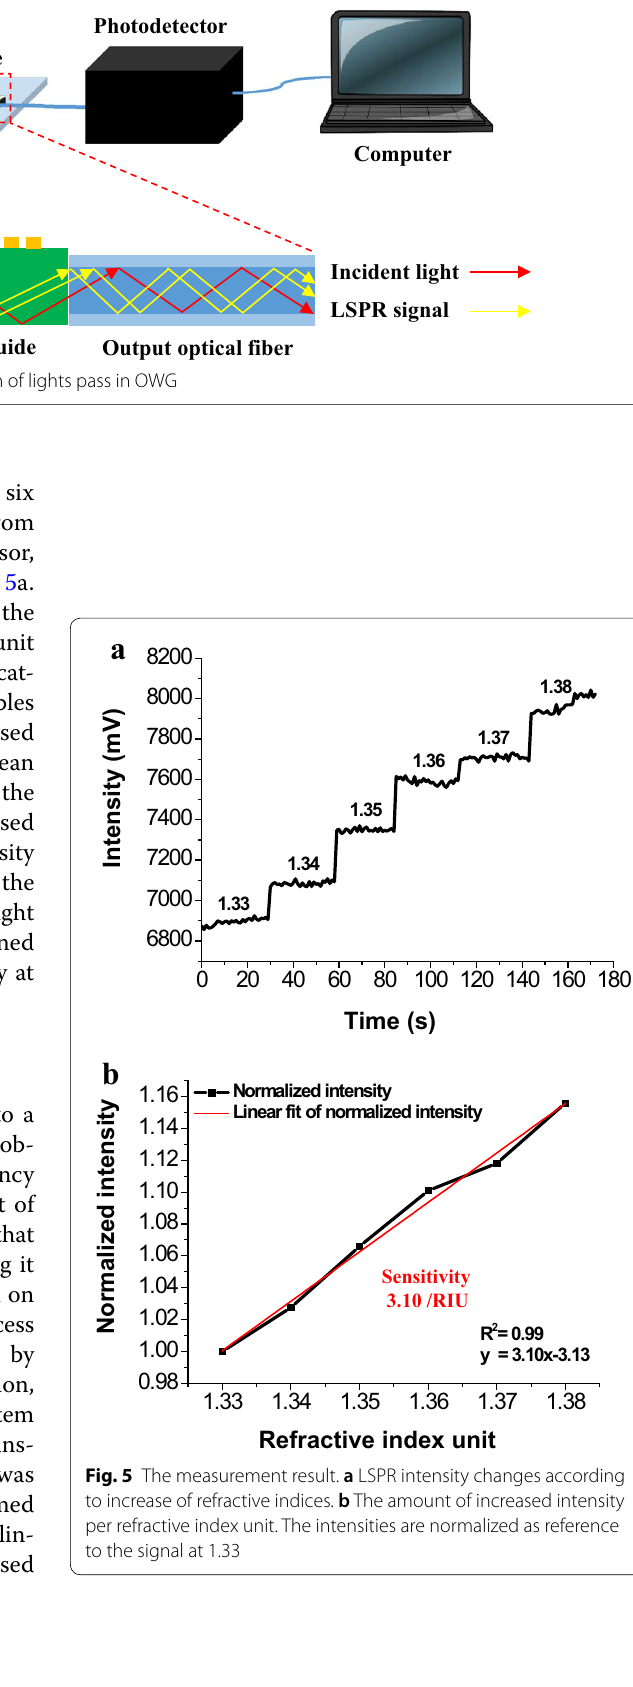
Fig. 5 The measurement result. a LSPR intensity changes according to increase of refractive indices. b The amount of increased intensity per refractive index unit. The intensities are normalized as reference to the signal at